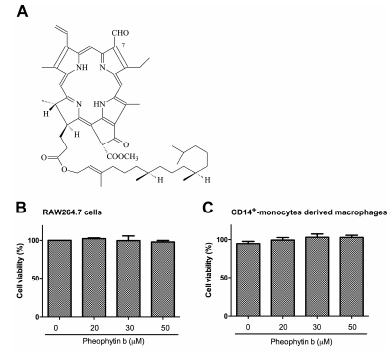
Figure 1. Pheophytin-b treatment had no significant effect on the viabilities of RAW 264.7 cells or human CD14 + monocyte-derived macrophages. ( A ) Chemical structure of pheophytin-b. Both RAW 264.7 cells ( B ) and human CD14 + monocyte-derived macrophages ( C ) were treated with pheophytin-b for 24 h at the indicated concentrations and viabilities were measured using an Alamar Blue assay. Data are expressed as the means ± standard deviations (SD) of five independent experiments ( n = 5).